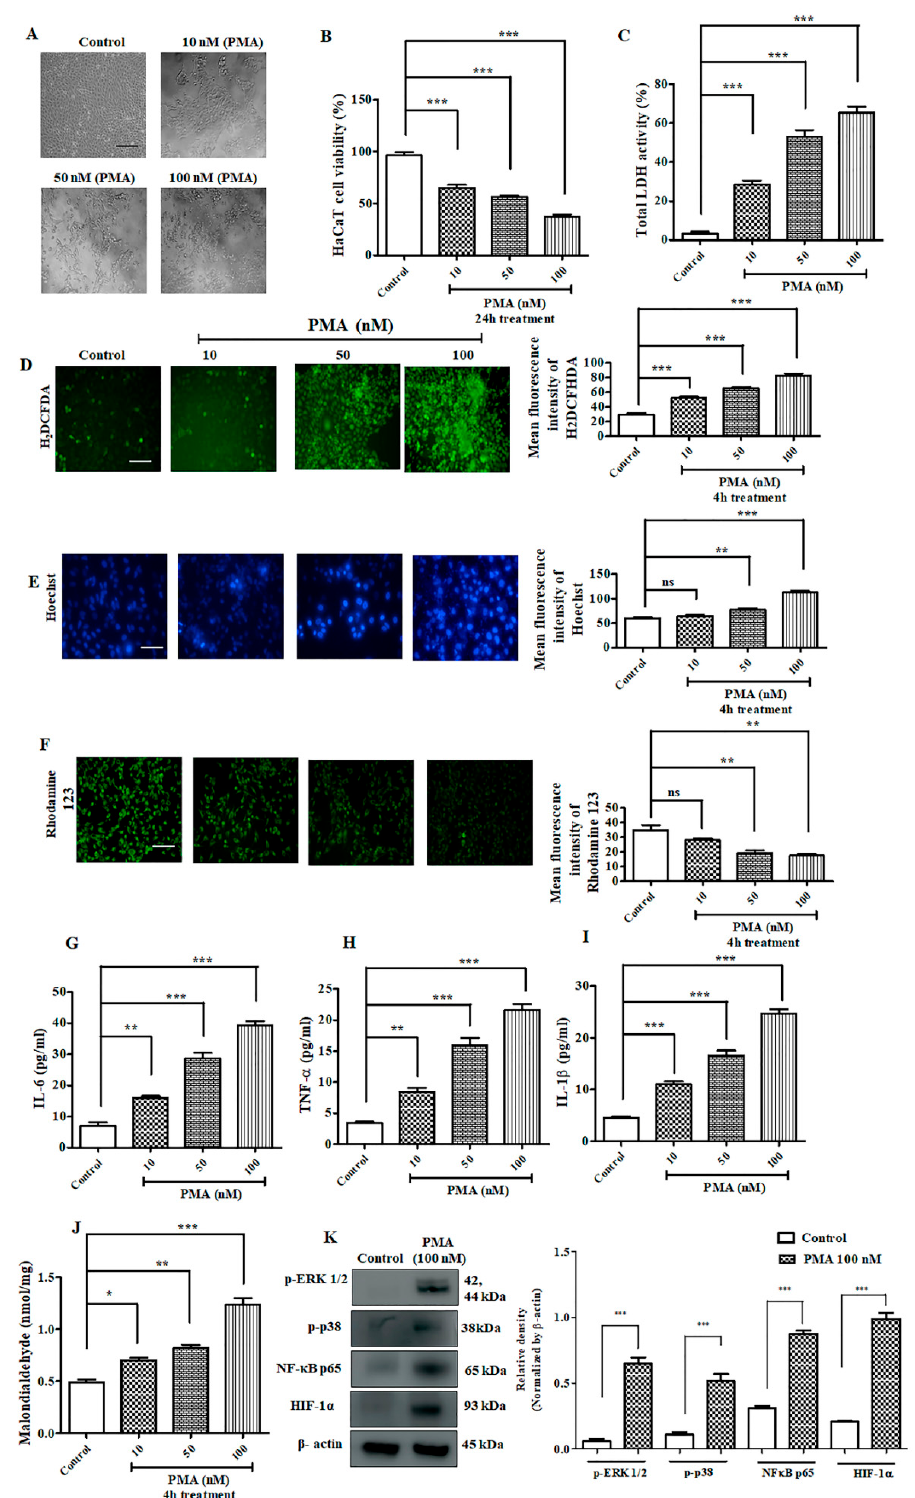
Figure 3. Effect of PMA on immortalized human keratinocyte (HACaT) cells. ( A ) Morphological image of HaCaT cells captured after 24 h of treatment with different concentration of PMA at different concentration (10 nM, 50 nM, 100 nM). Scale bar (100 μ M), ( B ) HaCaT cell viability after 24 h PMA treatment, ( C ) LDH assay on HaCaT cells after 24 h PMA treatment, ( D ) H 2 DCFDA staining on HaCaT cells after 4 h PMA treatment ( E ) Hoechst staining on HaCaT cells after 4 h PMA treatment, ( F )